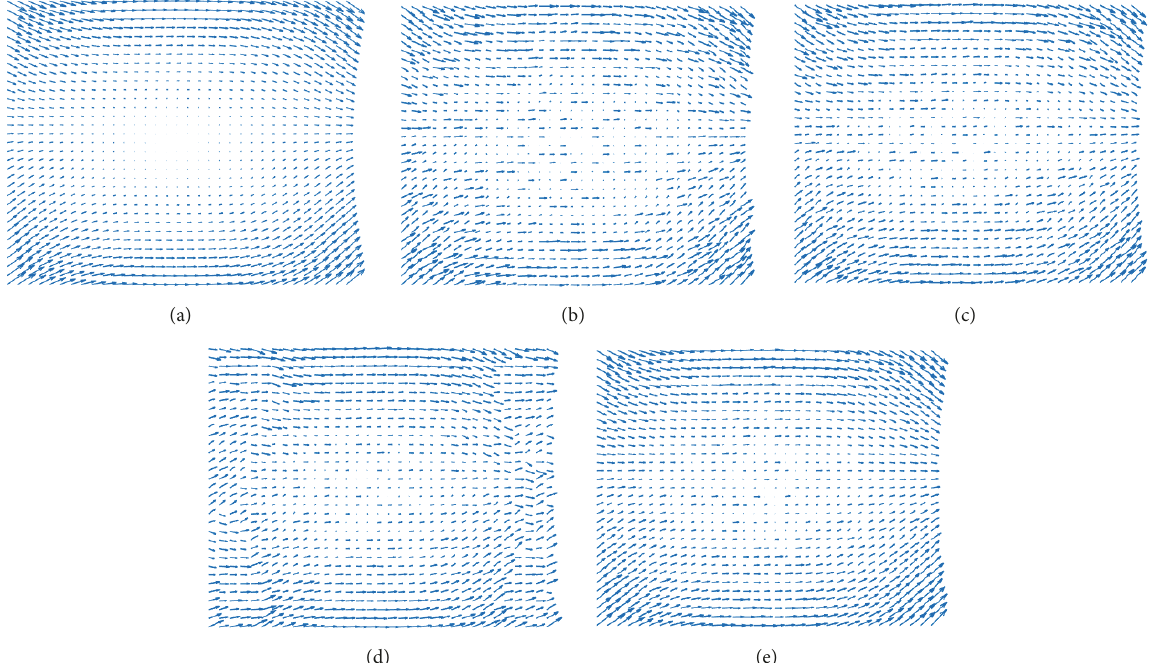
Figure 7: Plotted 𝑉 𝑥 and 𝑉 𝑦 components of the 3D analytical divergence-free vector field. (a) Original, (b) Gaussian noise added, (c) linear interpolation,(d) Horn-Schunckbased interpolation,and (e) proposed method. Note that the proposed method is able to achievea smoother velocity field in the corners of the interpolated data.